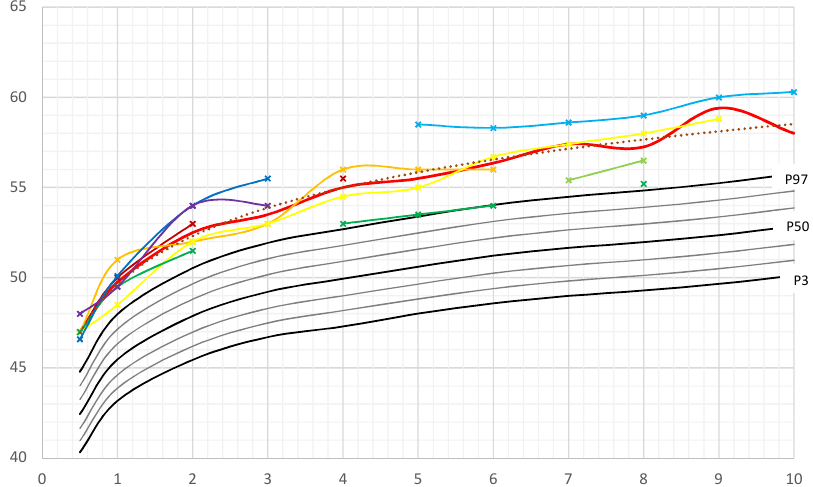
Figure 2. Head circumference (HC) of female PHTS patients in comparison to German reference growth charts [11]. Legend: ___(red): Median, ... ... : Trendline, ___: P3–P97. Colored lines: individual patient’s HC curves.